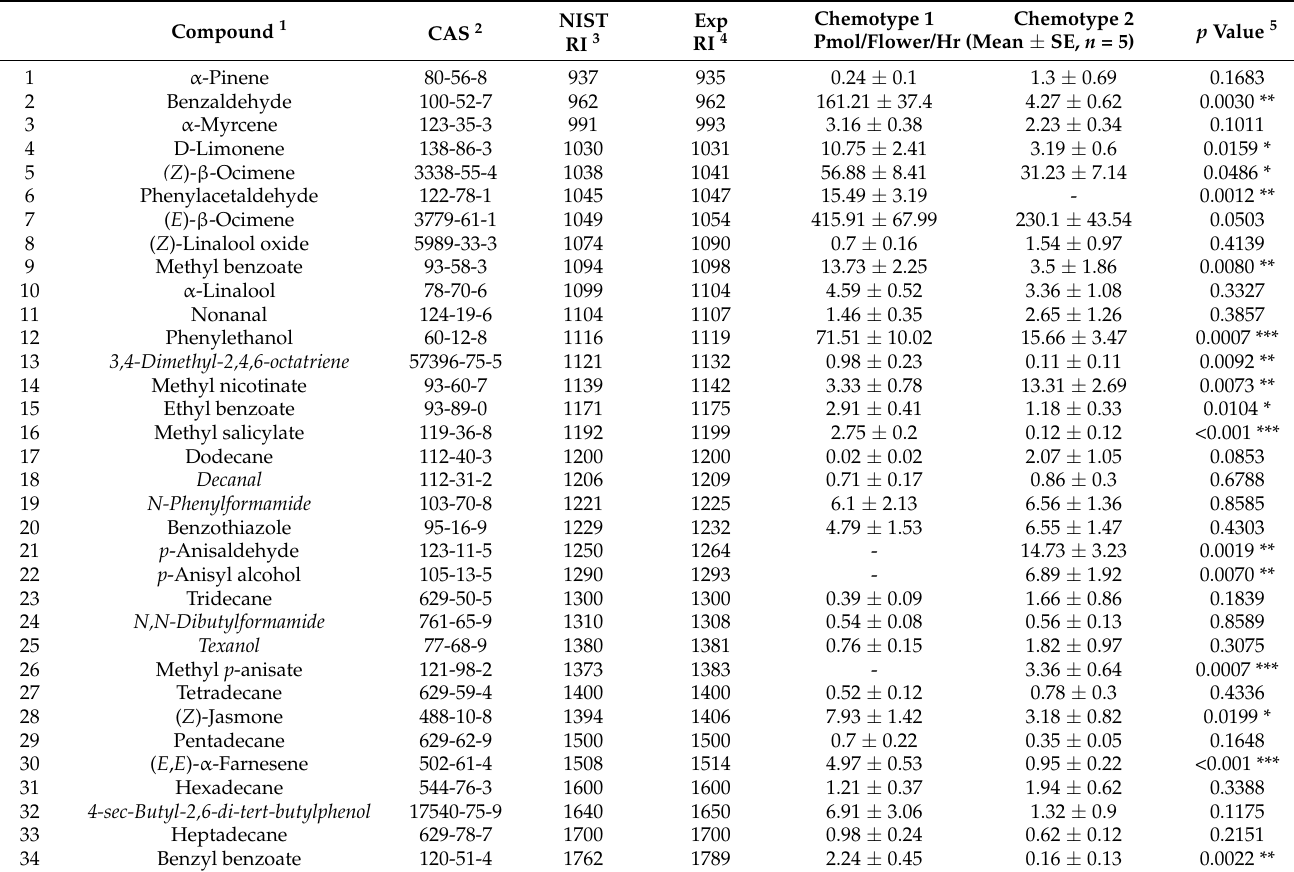
Table 2. Volatile organic compounds identified in the headspace of Prunus serotina